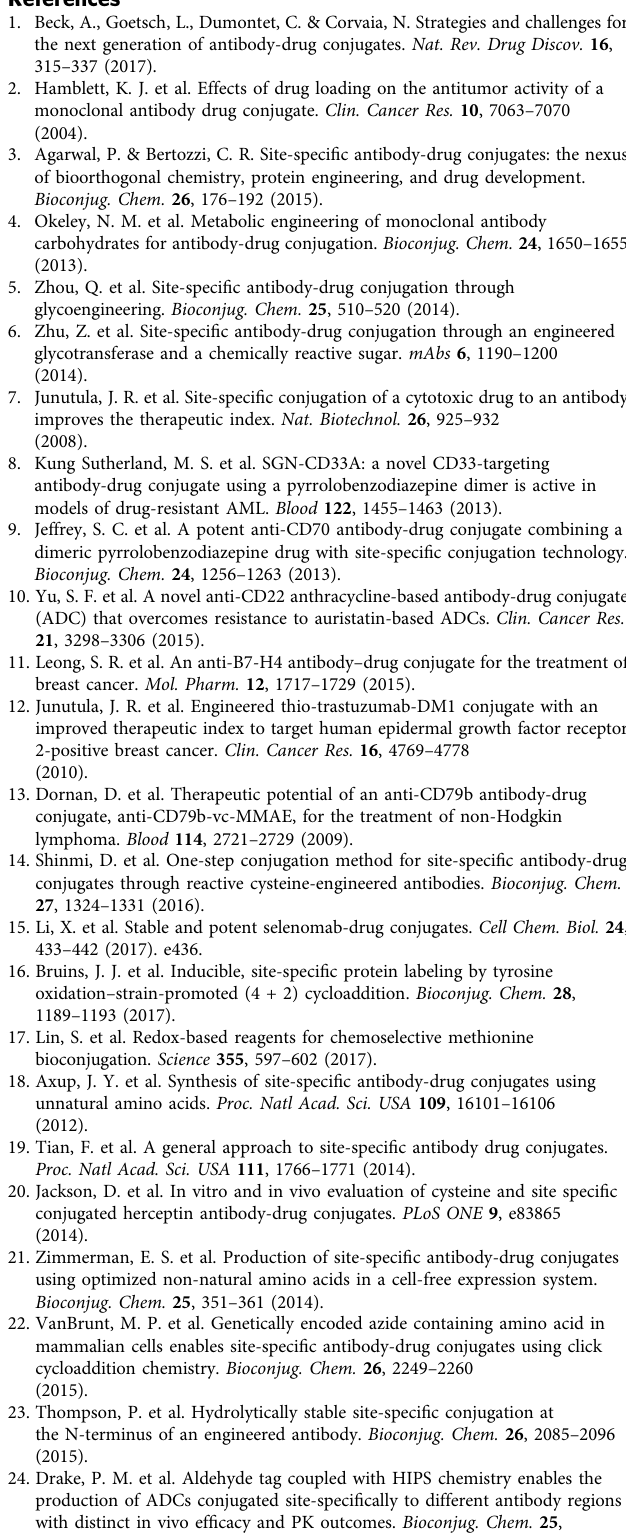
Table 1. The whole antibody had a Tregitope-Adjusted EpiMatrix Score of − 34.29. A regression analysis trained on FDA-approved and marketed mAbs with